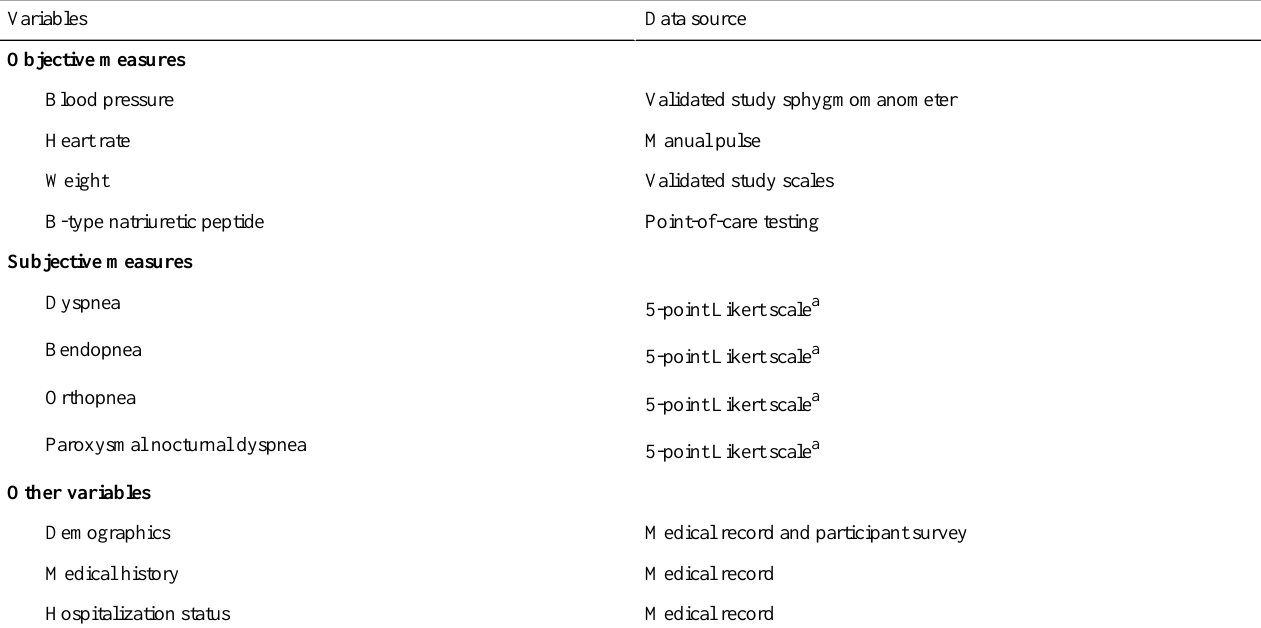
Table 1. Variables collected during study period and associated data